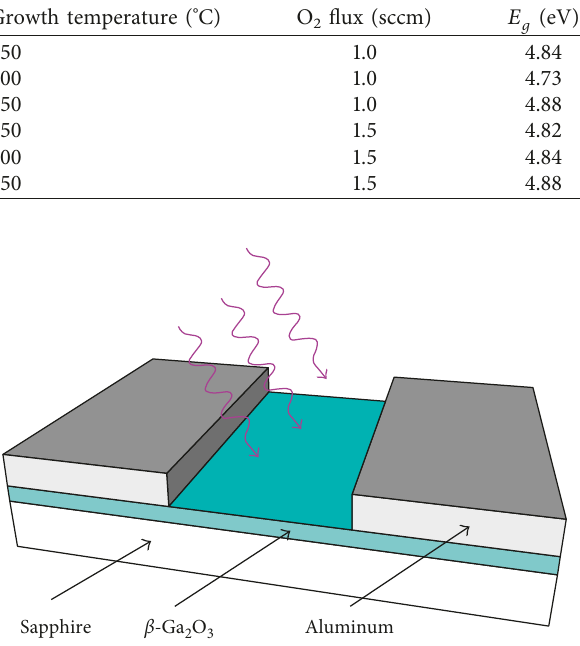
Figure 7: Schematic representation of the structure used in the I-V